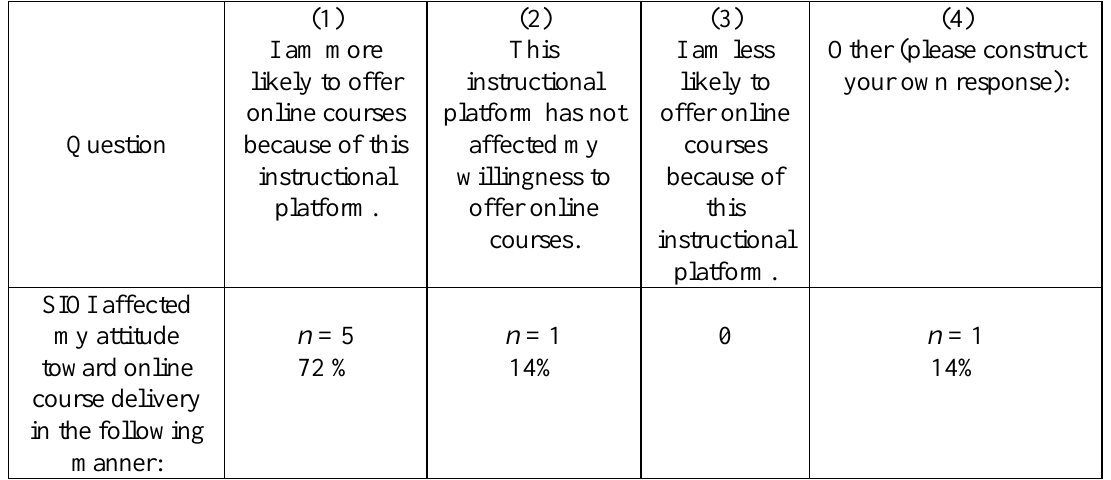
Respondents’ Inclination toward Future Use of SIOI